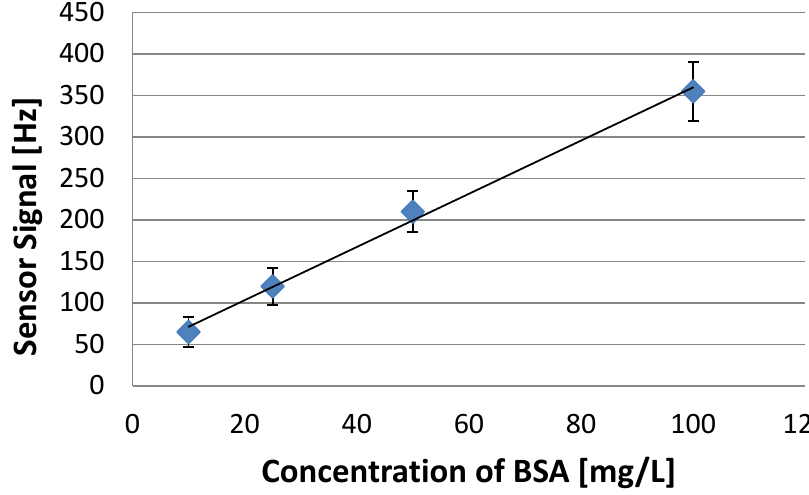
Figure 6. Sensor characteristic of the optimized polymer towards